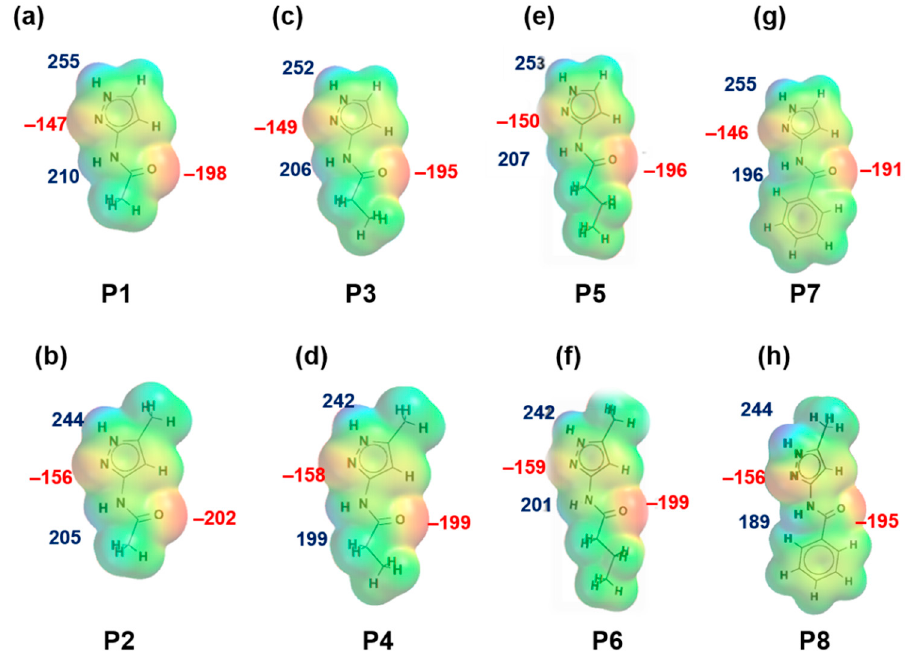
Figure 1. Electrostatic potential values (in kJ/mol); ( a ) P1, ( b ) P2, ( c ) P3, ( d ) P4, ( e ) P5, ( f ) P6, ( g ) P7 and ( h ) P8 . Red indicates MEPs on hydrogen-bond acceptors and blue indicates MEPs on hydrogen-bond donors.